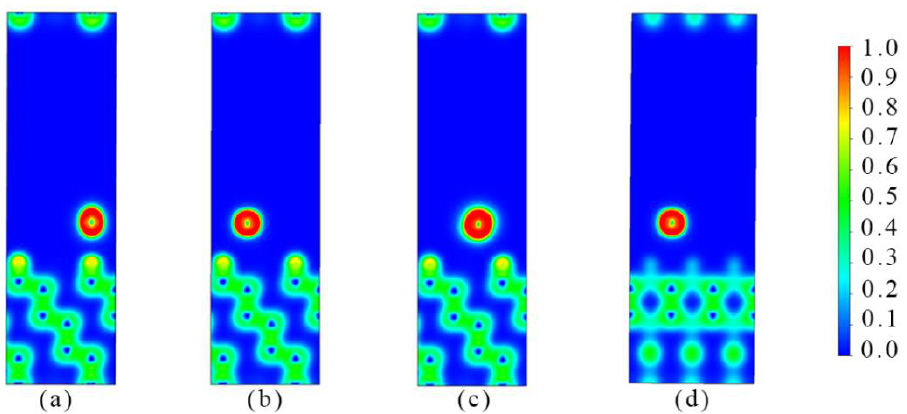
Figure 6. The 2D-ELF section views of four highly symmetric adsorption sites, where ( a – d ) show the Top, T4, H3, and Br adsorption sites, respectively.